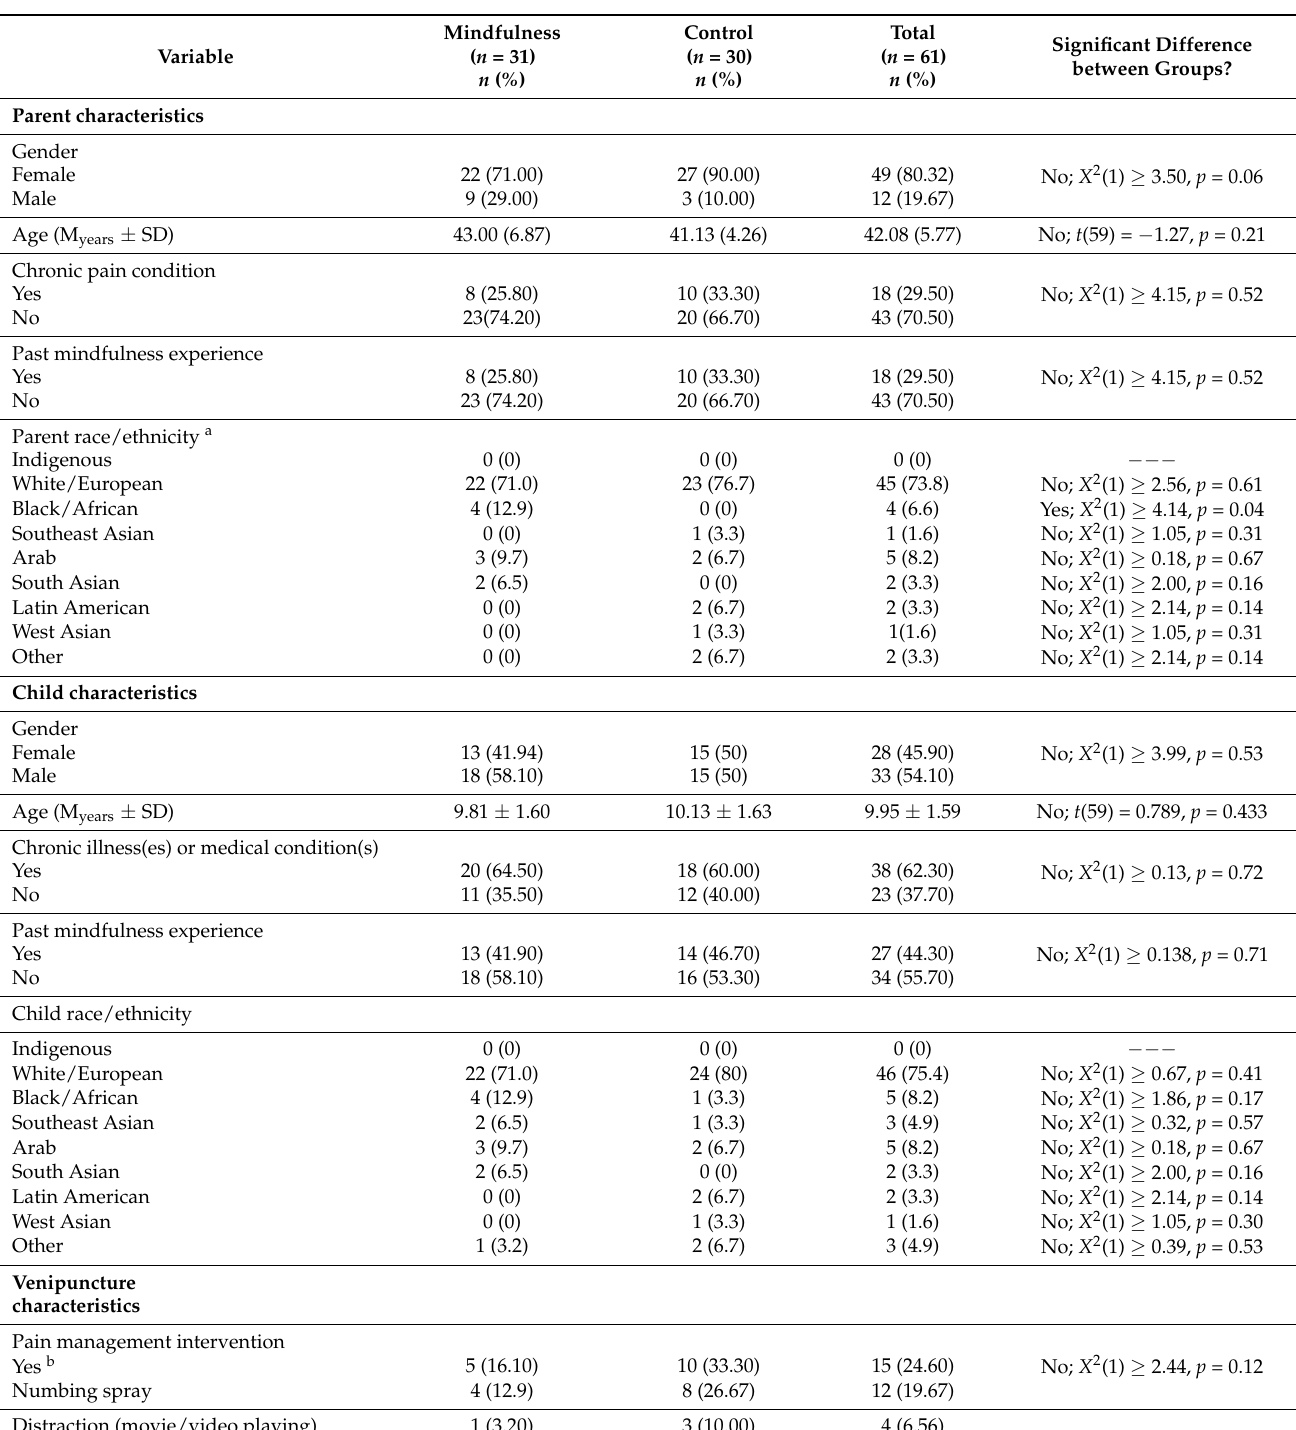
Table 1. Baseline demographic characteristics of participants and venipuncture